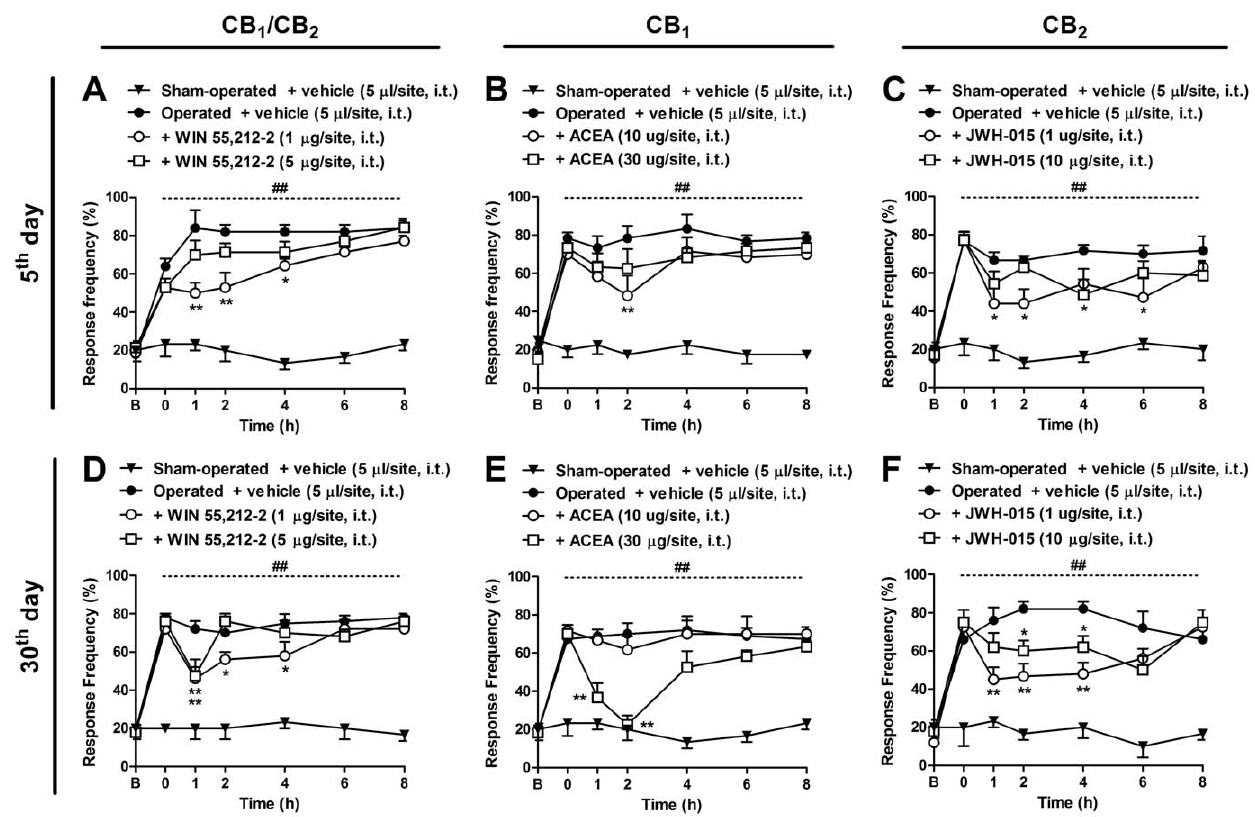
Figure 6. Effects of spinal (i.t.) administration of cannabinoid agonists on mechanical allodynia induced by brachial plexus avulsion (BPA) in mice. Response frequency of the right hindpaw assessed at several time-points in operated (BPA) mice treated with the non-selective CB 1 and CB 2 agonist, WIN 55,212-2 (1–5 m g/site, i.t.), the selective CB 1 agonist ACEA (10–30 m g/site, i.t.), the selective CB 2 agonist, JWH-015 (1–10 m g/site, i.t.) or vehicle (5 m l/site, i.t.), administered on the 5 th (A, B and C) or 30 th (D, E and F) day after surgery. Data are expressed as mean 6 SEM (n=4–6/ group). *p , 0.05 and **p , 0.01, significantly different from the operated group treated with vehicle (two-way ANOVA with Bonferroni’s post hoc test). B, Baseline withdrawal threshold before surgery. 0, baseline withdrawal threshold after surgery on the day of the experiment (5 th and 30 th days). analgesia for 6 h after treatment, with inhibition of 70 6 7% (two-way ANOVA, F=50.77, df=6 and p , 0.001 for time, and F=30.01, df=2 and p , 0.001 for treatment) and 91 6 15% (two-way ANOVA, F=56.48, df=6 and p , 0.001 for time, and F=29.68, df=2 and p , 0.001 for treatment), respectively (Figure 9B and D).